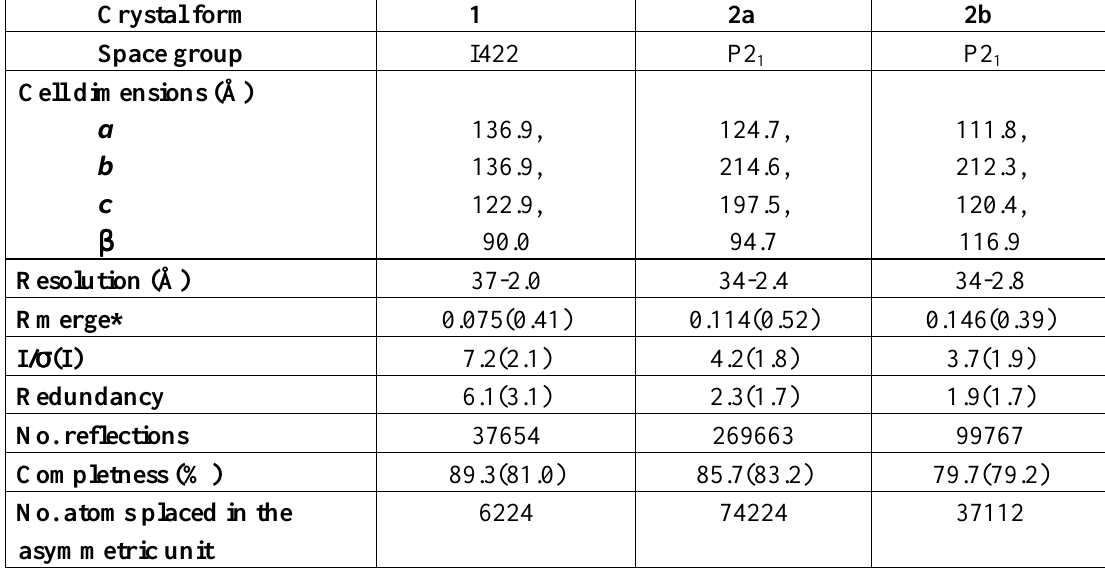
Table 1. X-ray data collection statistics and contents of the asymmetric unit for I422 and both P2 crystal 1